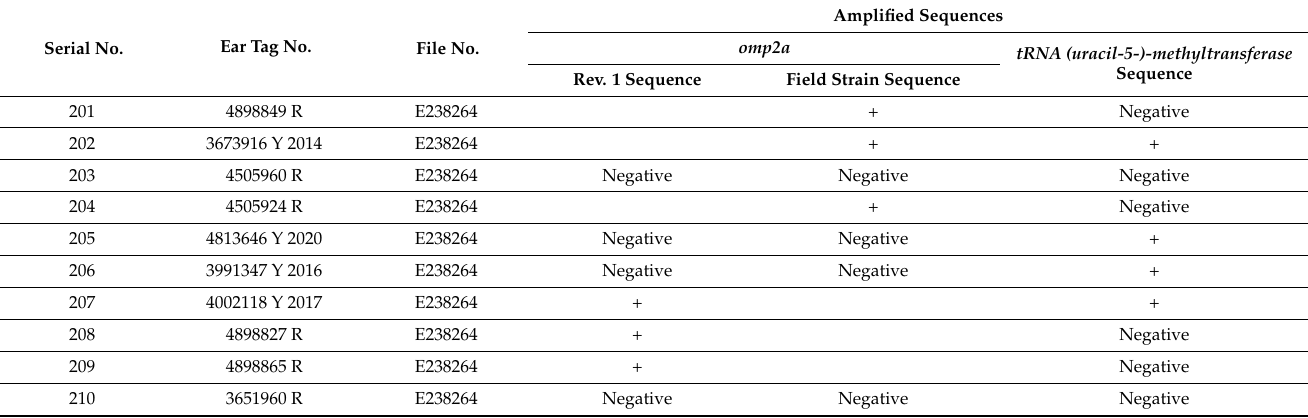
* omp2a and tRNA (uracil-5-)-methyltransferase serum PCR analyses of serum samples from ≥ 1:20 CFT positive sheep. The sequential order of the ear tag numbers indicates different times of visits of the flock (R—red; Y—yellow). Whereas Yellow labels indicate a true time of animal vaccination as young ewe-lambs, the red tag labeled animals indicate at least four visits of the flock, with some animals being retagged due to loss of the original